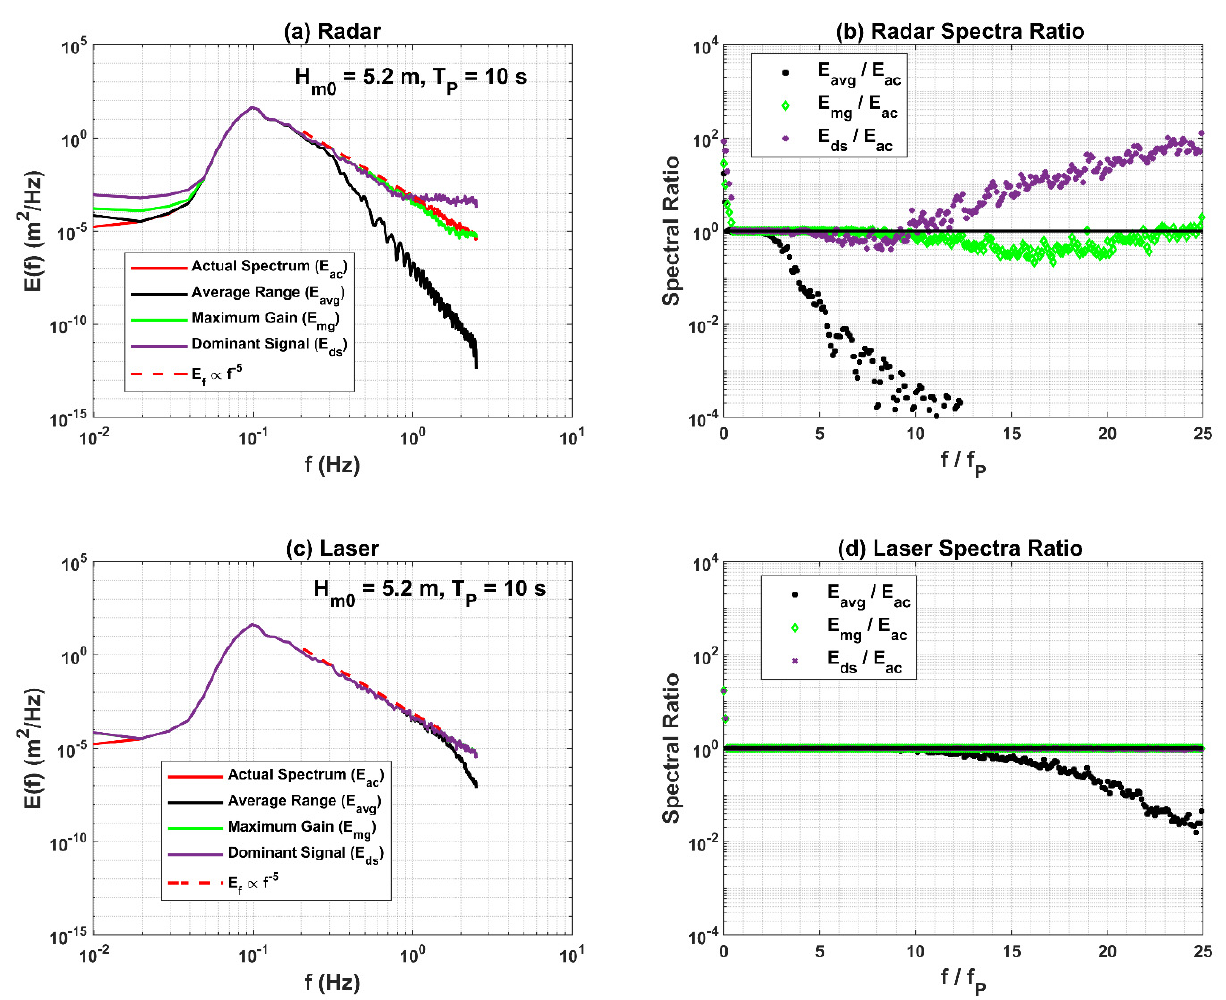
Figure 4. Comparison of one-dimensional frequency spectra estimated from actual surface elevations with the spectra derived from the simulated surface elevations of the Radar ( a , b ) and the Laser ( c , d ) from averaged ranges, ranges associated with maximum gain and dominant signals for a sea state with a significant wave height ( 𝐻 𝑚0 ) and peak frequency of 5.2 m and 0.1 Hz, respectively.